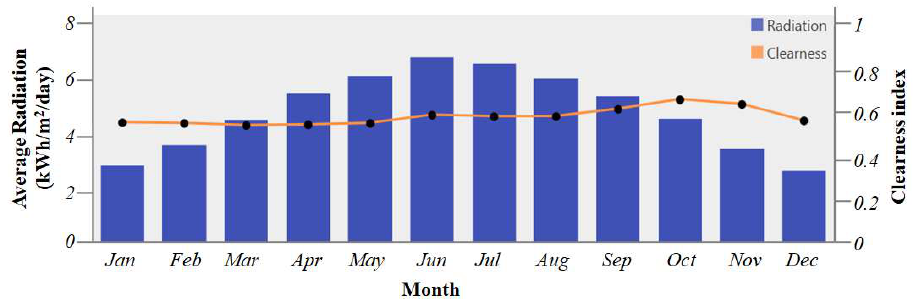
Figure 2. Solar irradiation and clearness index of the considered location.